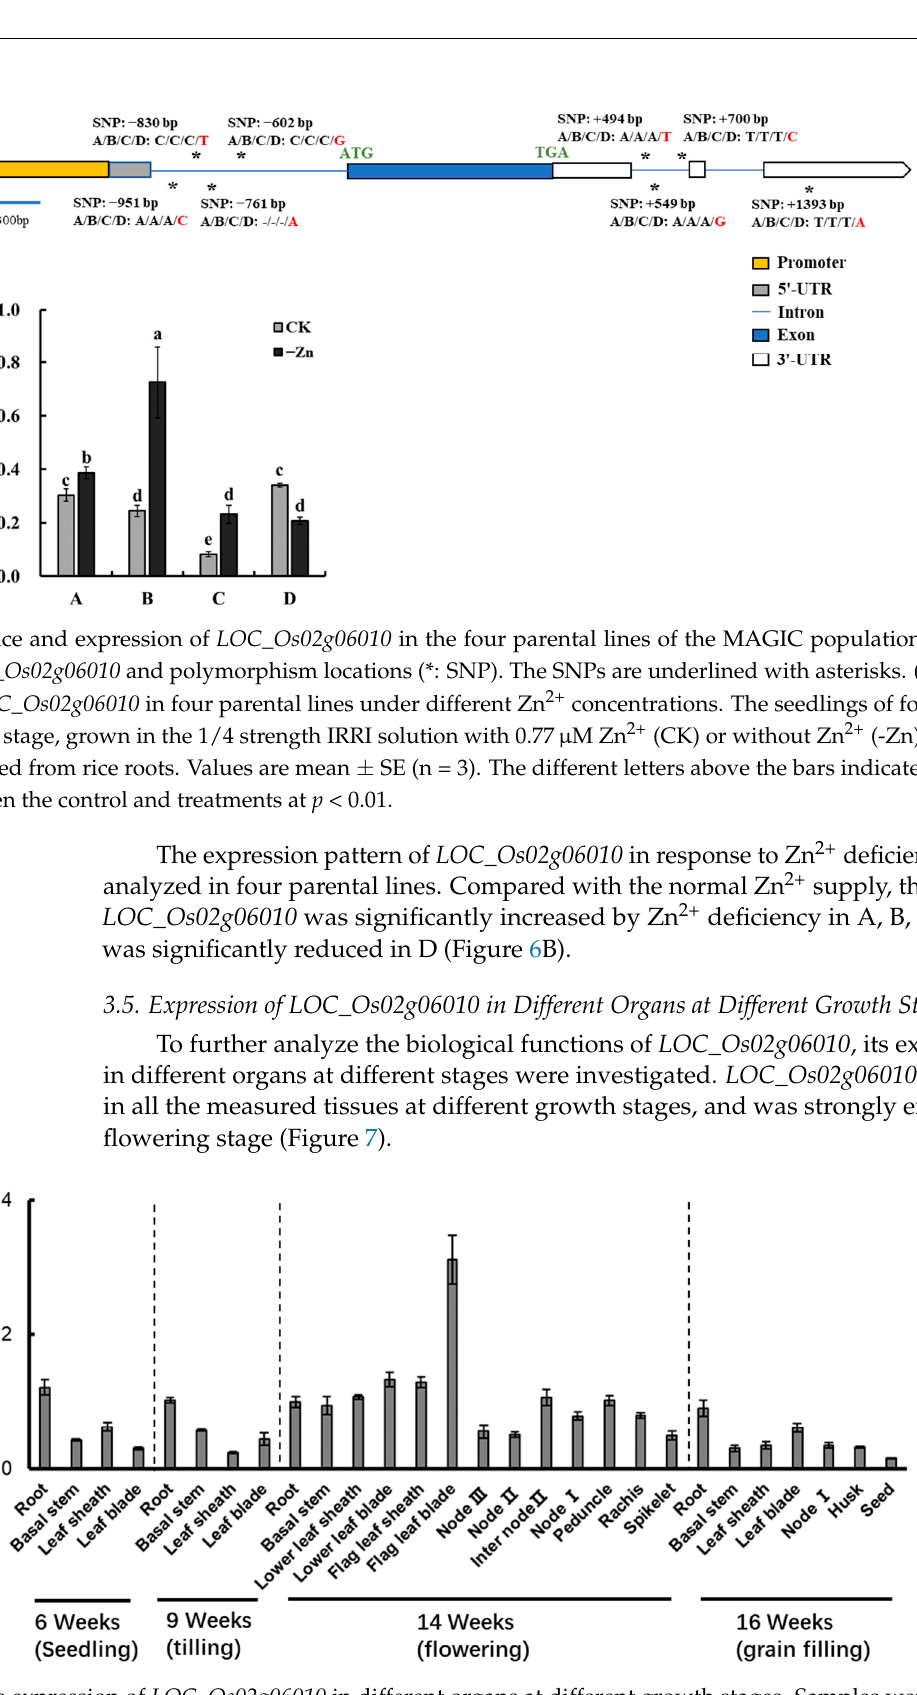
Figure 7. Relative expression of LOC_Os02g06010 in different organs at different growth stages. Samples were collected from cv. Nipponbare grown in a paddy field. Values are mean ± SE (n = 3).